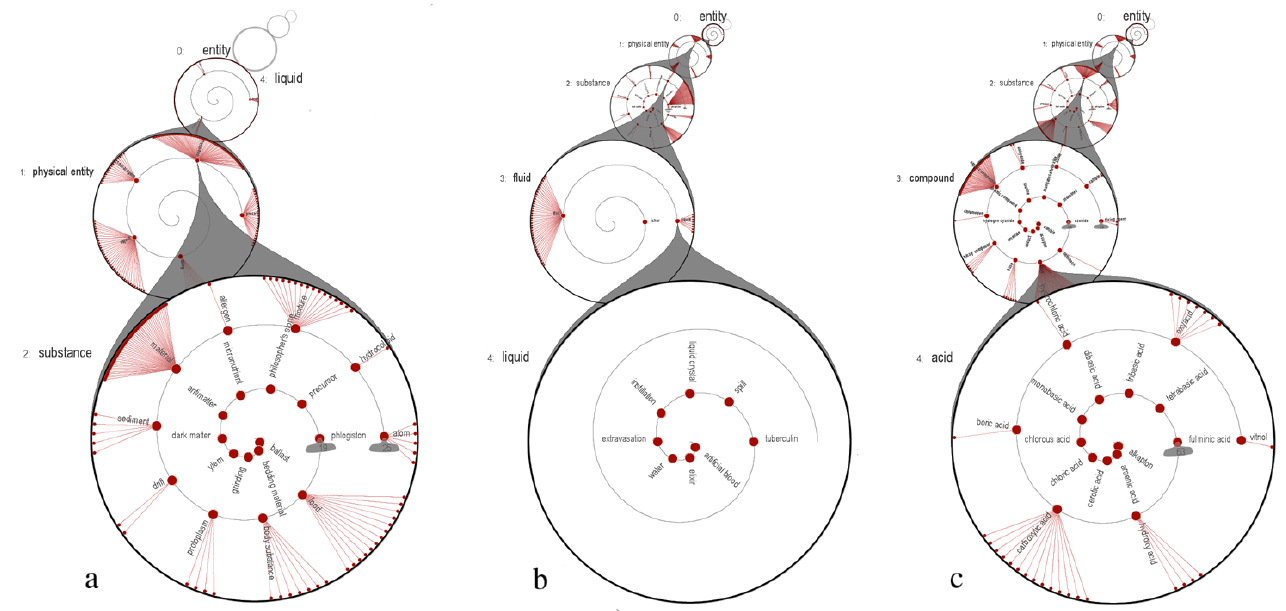
Figure 11. Select interaction steps in finding the hydrochloric acid node in the entity subtree of the WordNet [32] tree